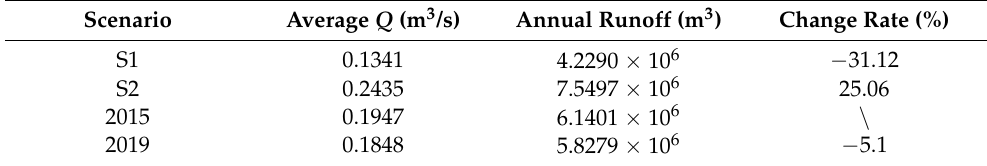
Figure 7. The simulated flow discharge at the downstream (outlet) point under the land use scenarios of S1, S2, and 2015. Table 4. The average flow discharge and average annual run off under the scenarios of S1, S2, 2015, and 2019.